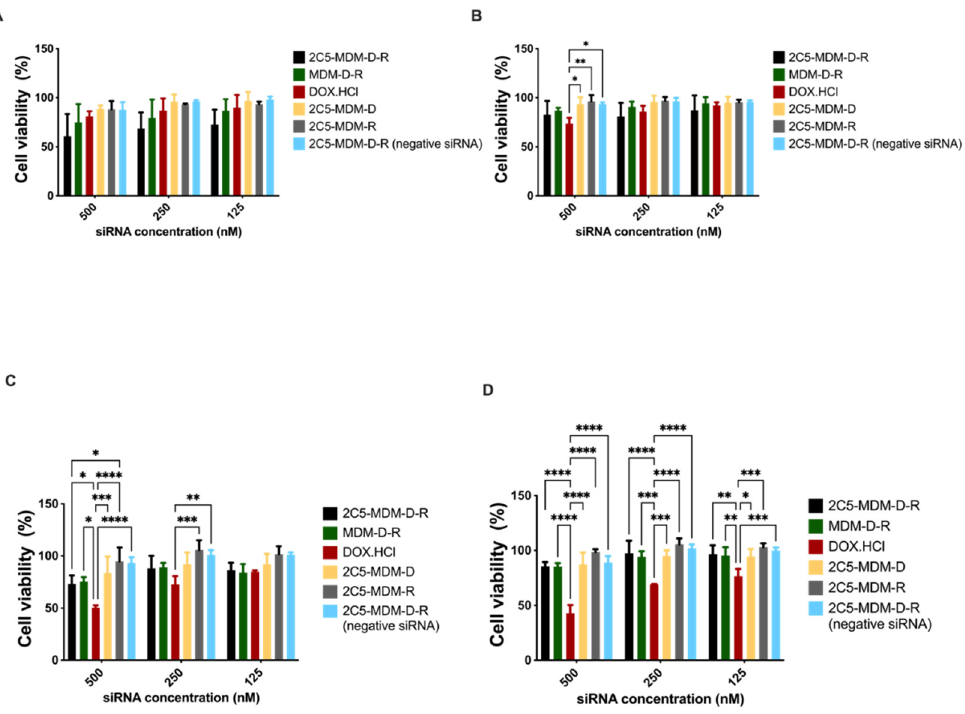
Figure 7. Cell titer blue (CTB) assay of 2D monolayer cytotoxicity study of Skov-3TR, ( A ) 1 h of treatment and 23 h of recovery, ( B ) 2 h treatment and 22 h of recovery, ( C ) 1 h treatment and 47 h of recovery, ( D ) 2 h treatment and 46 h of recovery. Results indicate ± SD (n = 3), and significance was calculated with two-way ANOVA comparisons. **** p ≤ 0.0001, *** p ≤ 0.001, ** p ≤ 0.01, * p ≤ 0.05.